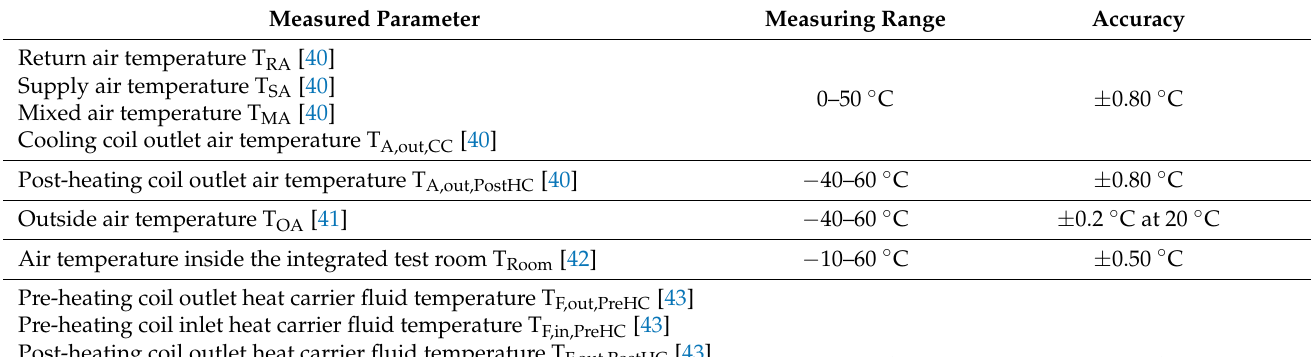
Table 3. Characteristics of the AHU